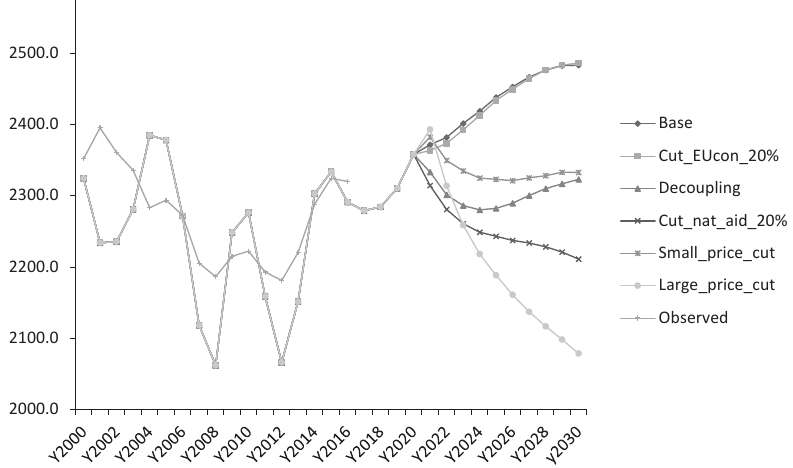
Fig. 3. Simulated milk production (million litres) 2000–2029 in different scenarios vs observed milk production 2000–2016 in